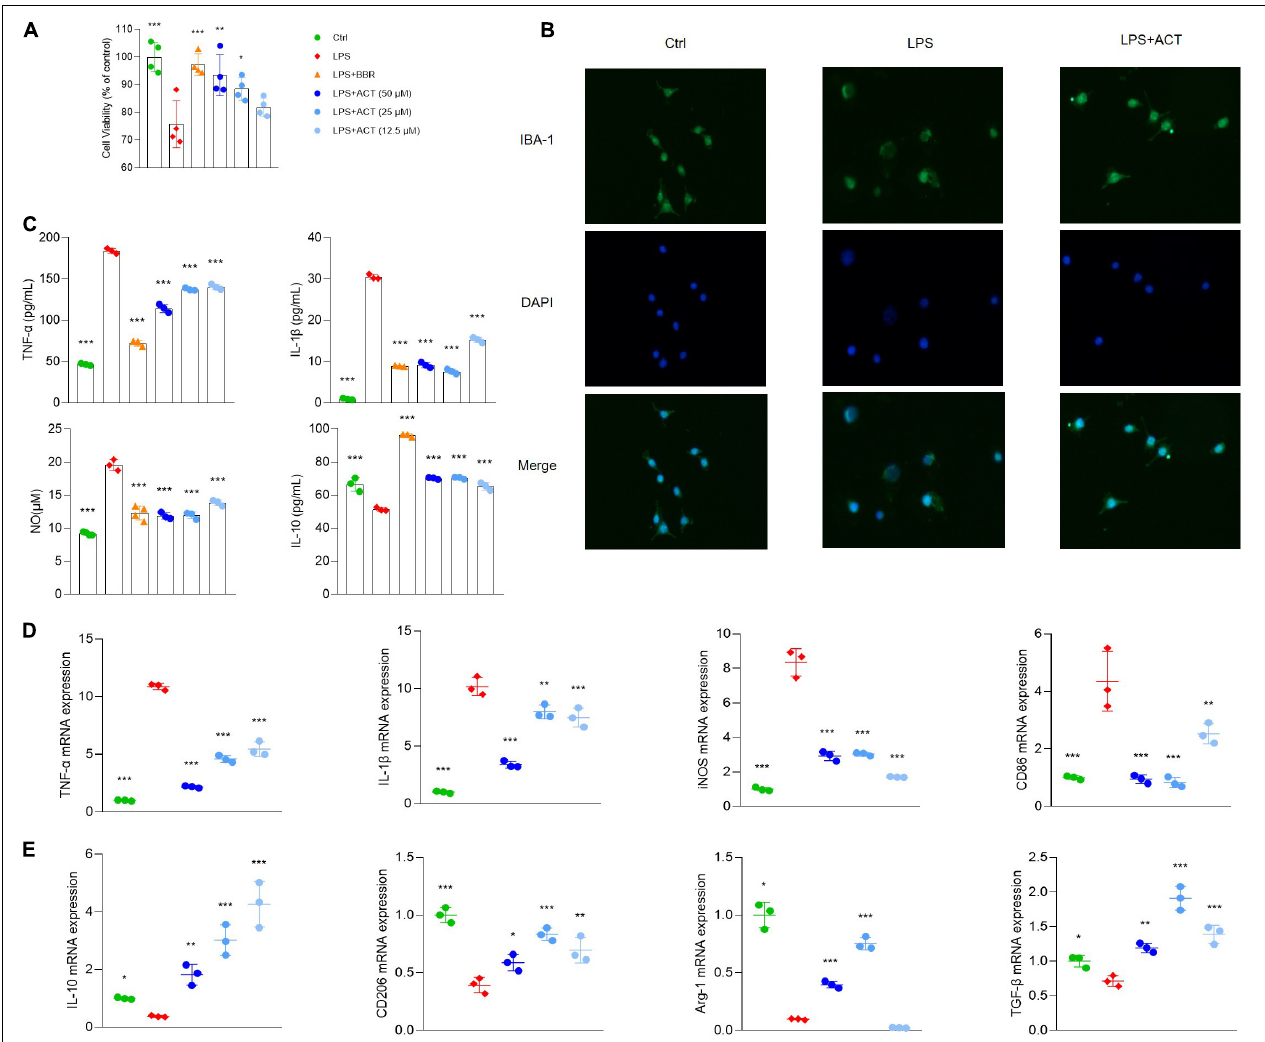
FIGURE 2 | ACT regulated M1/M2 polarization in LPS-stimulated BV-2 cells. (A) Effects of ACT on LPS-induced BV-2 cell viability. (B) Cell morphology with IBA-1 staining was observed with inverted phase contrast fluorescence microscope ( × 10). The control group exhibited small soma with distal arborization, showing the typical ramified morphology of resting microglia. The LPS group became fewer and shorter branches with a greatly enlarged cell body, the characteristic shapes of activated microglia. The ACT groups showed attenuated LPS-induced morphological changes. (C) Effects of ACT on LPS-induced elevation of cell supernatant TNF- α , IL-1 β , and IL-10 levels as well as NO elevation. * P < 0.05, *** P < 0.005, versus the LPS group. n = 3. Berberine (BBR) as a positive control. (D) Effects of ACT on M1 microglia polarization related markers. (E) Effect of ACT on M2 microglia polarization related markers. * P < 0.05, ** P < 0.01, *** P < 0.005, versus the LPS group. n =